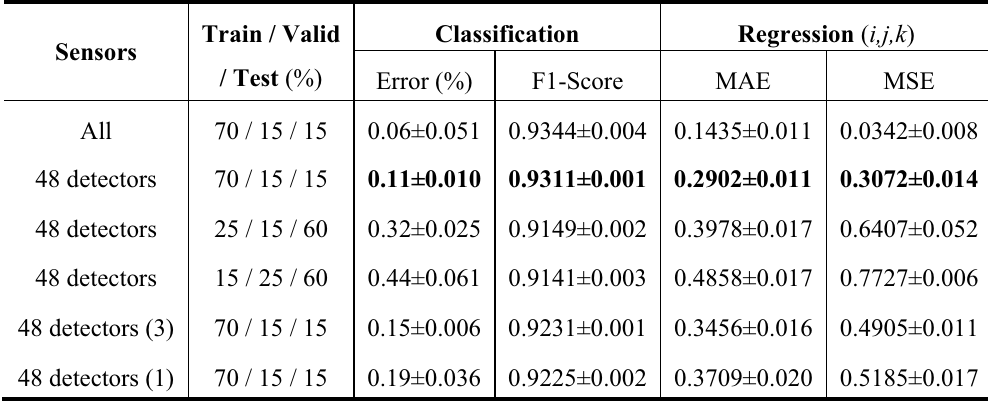
(cid:14) Table I. Comparative results of the proposed 3D DenseNet: ( ) denotes the SNR of the noise added. Each model was run three times and the results are given as an average and standard